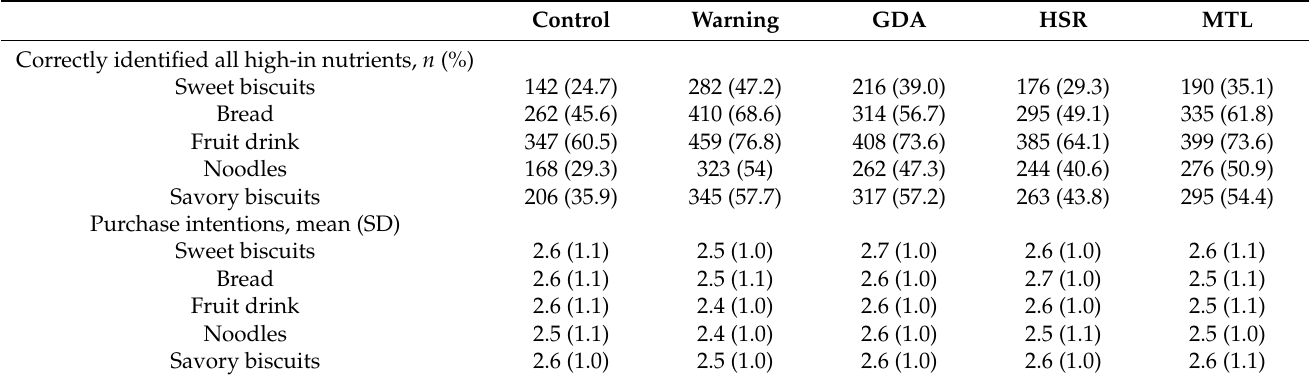
Table A4. Descriptive statistics on the primary outcomes by study arm and product type ( n =